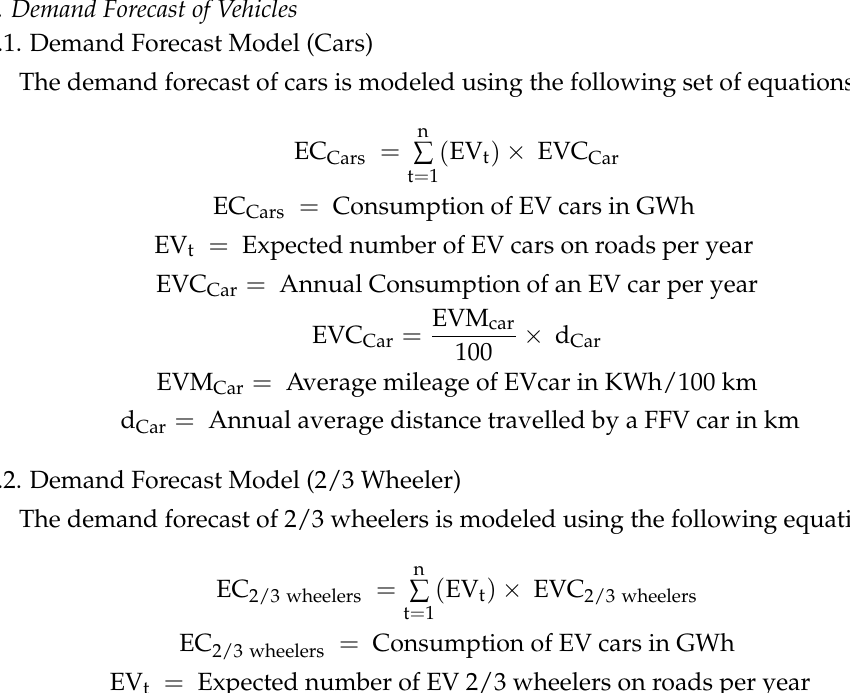
Figure 5. Methodology of the EV load growth model.